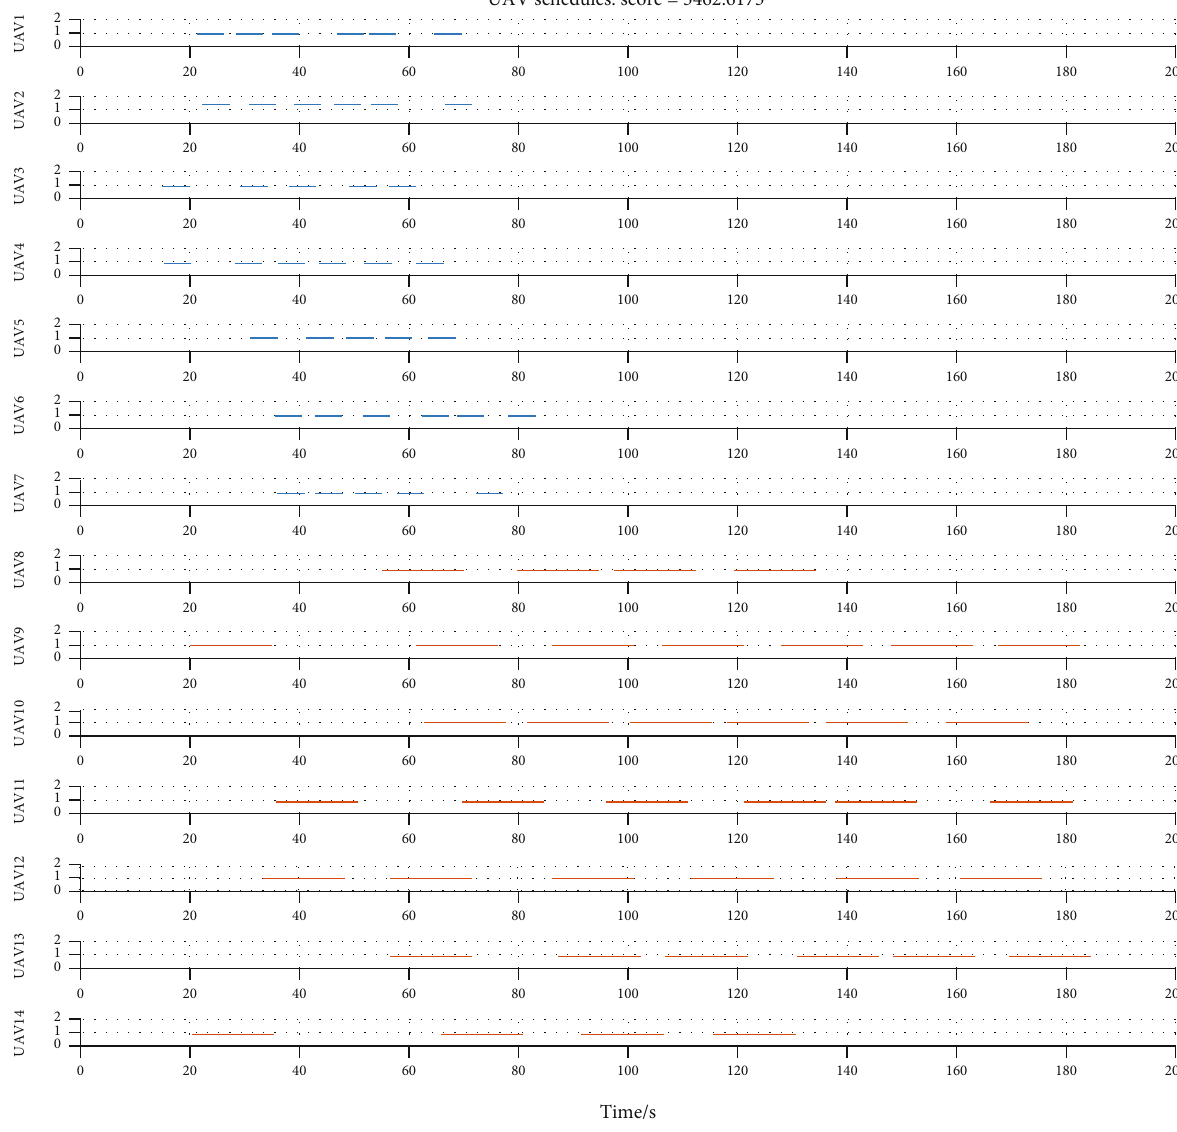
Figure 8: UAV schedules of MDA-DCNM with unbalanced capacities of R